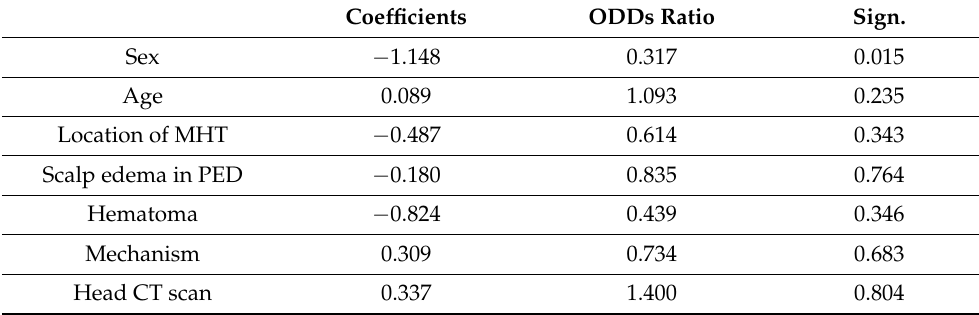
Table 5. The angular coefficients of linear regression lines for post-traumatic headache (PTH) inci- dence (dependent variable), ODDs ratio, and the risk factors (independent variables, rows) are shown. In the case of gait instability, orthopedic injuries were ruled out by physical and/or radiological examination. Amnesia includes loss of memory of the events both preceding and following